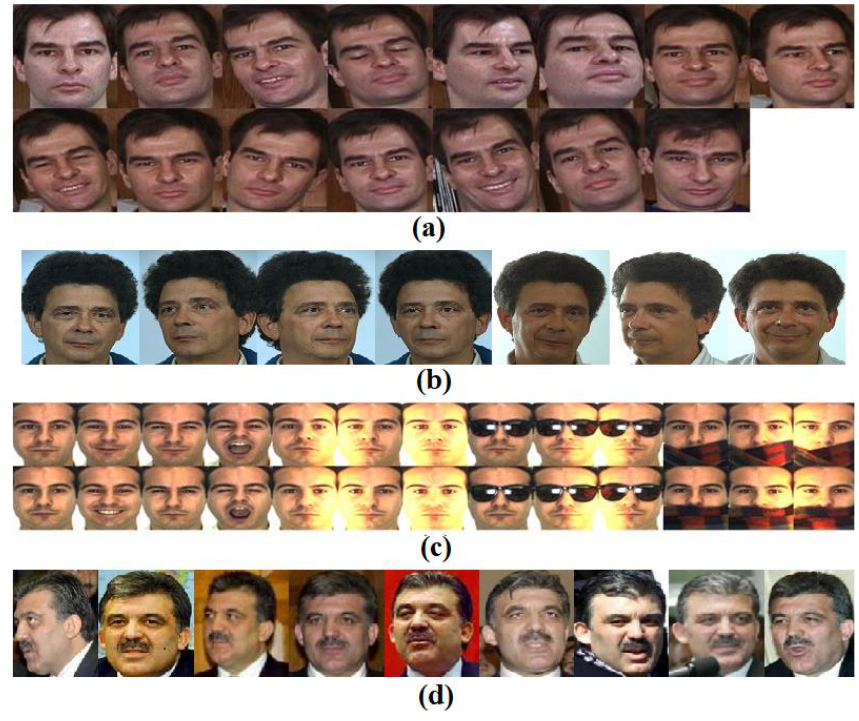
Figure 2. Sample for color face image ( a ) Georgia Tech; ( b ) Color FERET; ( c ) AR; ( d ) and LFW-A.